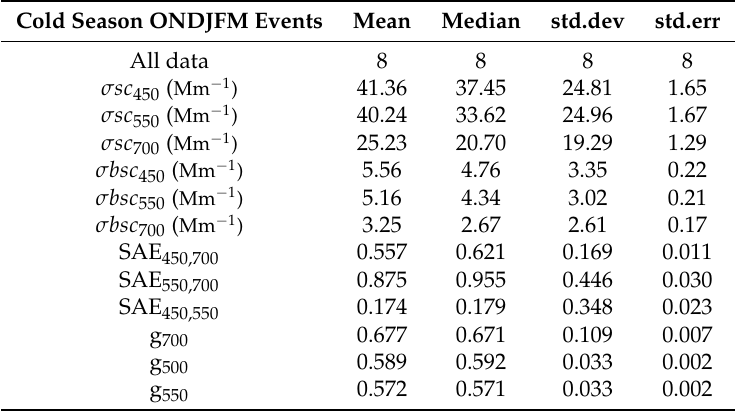
Table 7. Statistics ( σ sc , σ bsc , SAE, g), at LMT Observatory, all selected dust events in cold season.